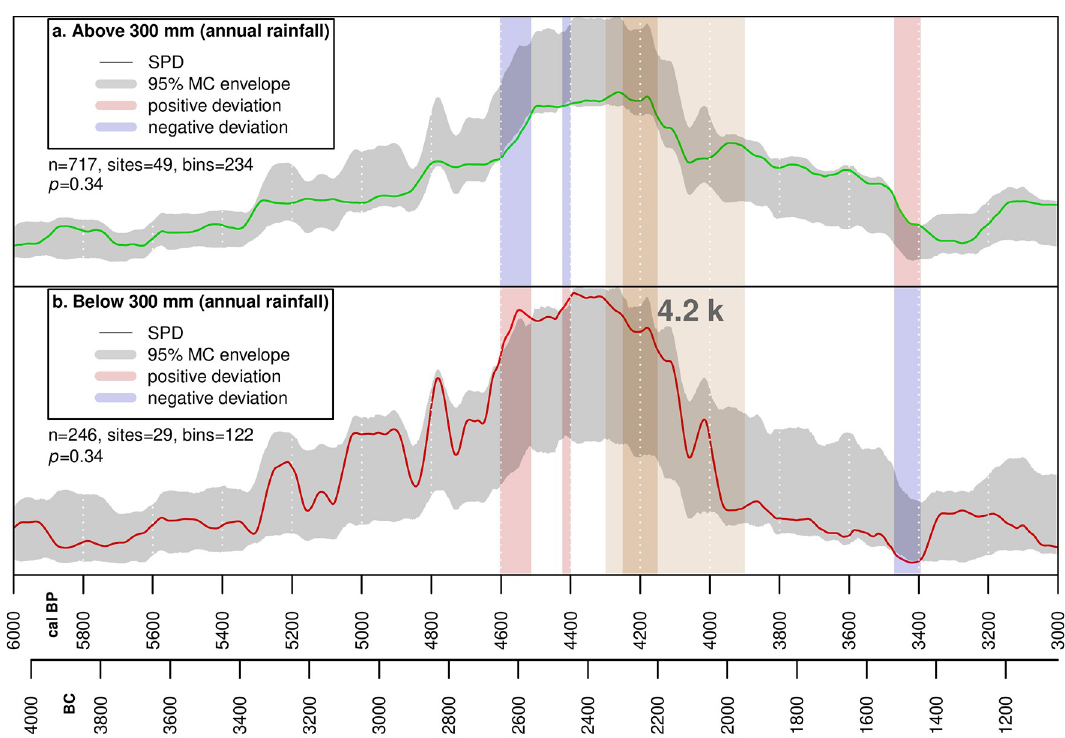
Fig 3. Summed probability distribution permutation test. a: Dates from sites located in areas with greater than 300 mm annual rainfall. b: Dates from sites located in areas with less than 300 mm annual rainfall.